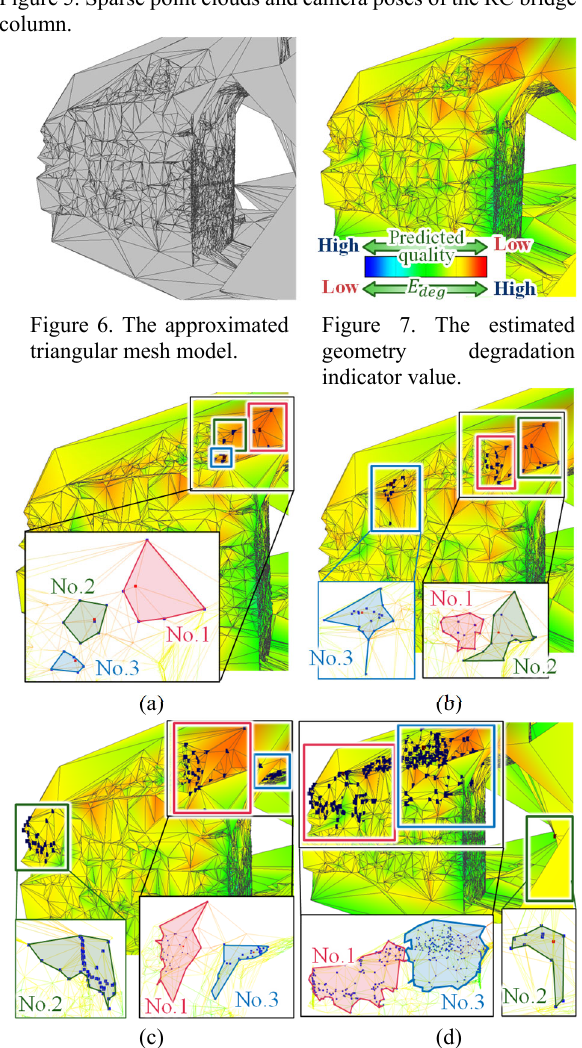
Figure 8. The selected low-quality regions; (a) 𝑘 (cid:3404) 1 by condition 2a, (b) 𝑘 (cid:3404) 2 by condition 2a, (c) 𝑘 (cid:3404) 3 by condition dot indicates a shooting target point.